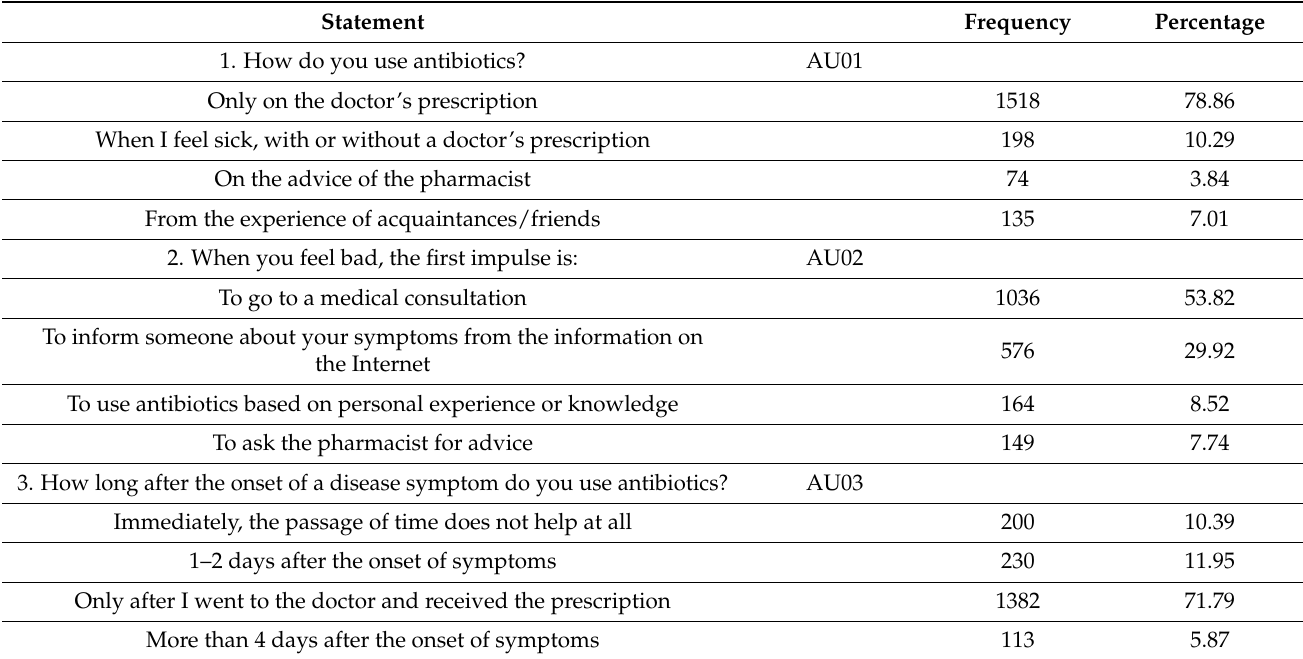
Table 5. Respondents’ antibiotic use